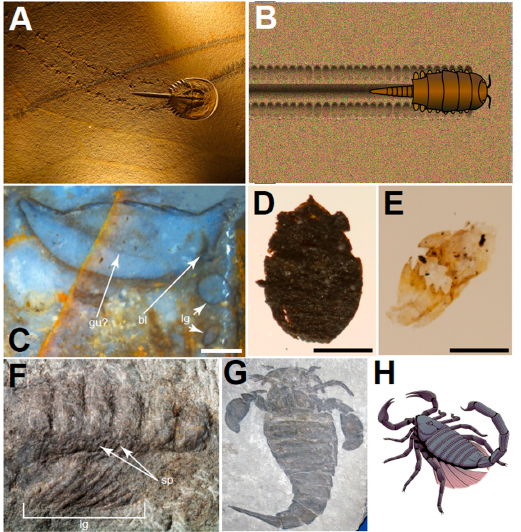
Figure 1. Fossil evidence of arthropod terrestrialization. ( A ) Traces and the body fossil of the horseshoe crab that made it, Mesolimulus walchi , morphologically resembling modern forms; ( B ) recon- struction of a terrestrial Cambrian ichnofossil, possibly made by the euthycarcinoid Mosineia, a group in kinship with myriapods; ( C ) Section through the abdomen of a trigonotarbid arachnid preserved in the Early Devonian Rhynie chert, revealing book lungs (bl), a possible trace of the gut (gu?), and sections through the legs (lg); ( D ) Carbonised body fossil of a trigonotarbid arachnid Palaeotarbus jerami from the Silurian Ludford Lane; ( E ) Putative myriapod mandibles from the Silu- rian Ludford Lane; ( F ) Millipede Pneumodesmus newmani from the Lower Devonian of Cowie Har- bour (Scotland), presenting spiracles (sp) and legs (lg); ( G ) Eurypterid Eurypterus remipes from the Silurian; ( H ) Palaeoreconstruction of the Devonian scorpion Waeringoscorpio westerwaldensis , with filamentous gills that suggest a potential aquatic adaptation. Image sources: Wikimedia Commons Illustration authors: ( B ) Haug; ( C – E ), Erik Tihelka; ( H ) Junnn11 (@ni075). Institutional repositories: ( C – F ) National Museum of Scotland, Edinburgh: R.08.14 & G.2001.109.1; ( D , E ) Ulster Museum, Bel- fast: K25850 & LL1.6-23; ( G ) Generaldirektion Kulturelles Erbe, Direktion Archiolo- gie/Erdgeschichte, Mainz, Germany, based on PWL2007/5000-LS. Scale bars: ( C , D ) 500 μ m, ( E ) 250 μ m, ( G ) ~10 mm. 2. Origin and Terrestrialization of Arthropods 2.1. Arthropod Origins It is difficult to precisely estimate terrestrial arthropod biodiversity in deep time due to the caveats of the fossil record; terrestrial arthropod fossils are usually limited to sites of exceptional preservation known as Konservat - Lagerstätten , and therefore their strati- graphic and environmental distribution is discontinuous. However, we can suppose that, as in the modern biosphere, arthropods were probably the largest component of the di- versity and abundance of Palaeozoic land animals, given the lack of initial competition and the phylogenetic diversity of those that are present in the terrestrial Palaeozoic fossil record. Indeed, arthropods are likely to have been the dominant animal group in terms of biodiversity in perpetuity for the past 520 million years [54]. Arthropods are characterised by presenting internal and external body segmentation with regional specialisations (tag- mosis: in the case of insects, for example, they possess a thorax where legs and wings are inserted while there are no extremities in the abdomen); an external skeleton composed of articulated sclerotized parts; body segments that originally had associated articulated